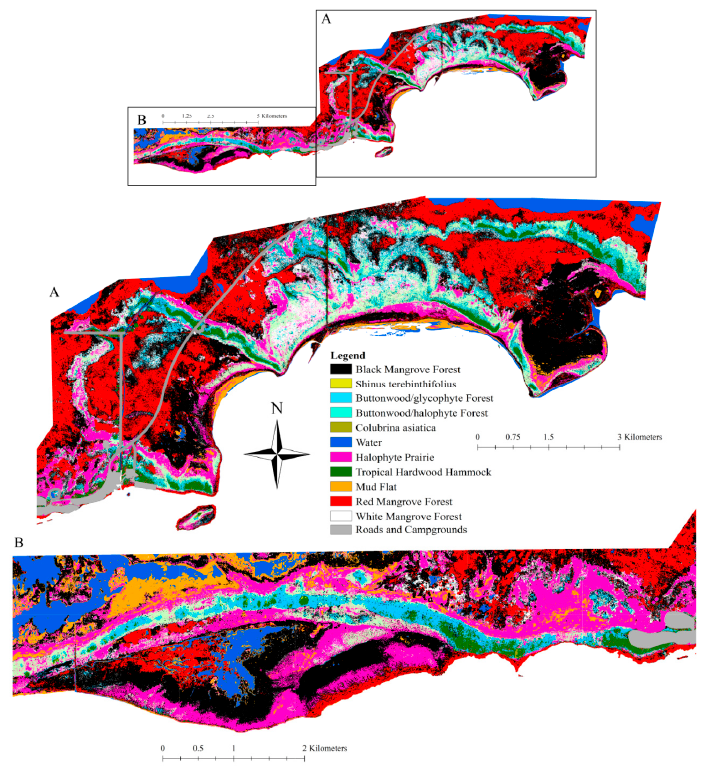
Figure 2. The 20 m 2 resolution vegetation map of the 71 km 2 study area, Flamingo, Everglades National Park. The overview shows the entire 71 km 2 area. ( A ) The enlarged eastern portion of the map; ( B ) the enlarged western portion.